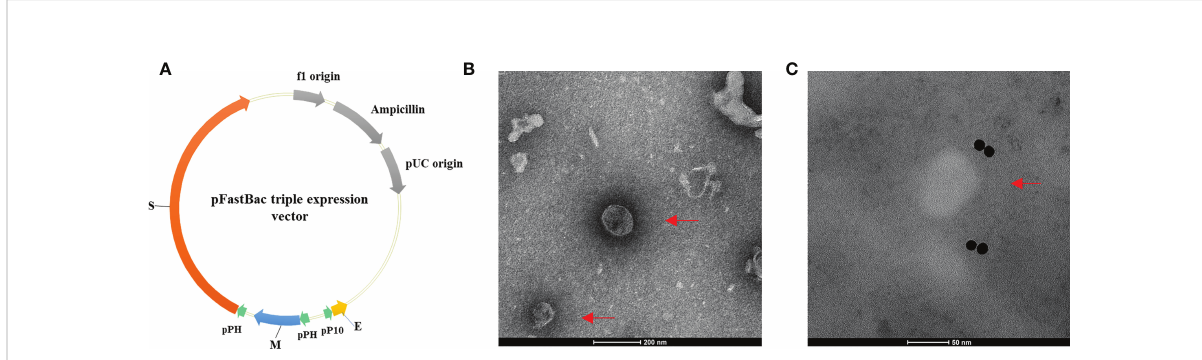
electron microscope. Red arrows denote VLPs. (B) SARS-CoV-2 VLPs stained with phosphotungstic acid. Scale bar = 200 nm. (C) Negative stain electron microscopy reveals SARS-CoV-2 VLPs speci fi cally labeled with immunogold. Scale bar = 50